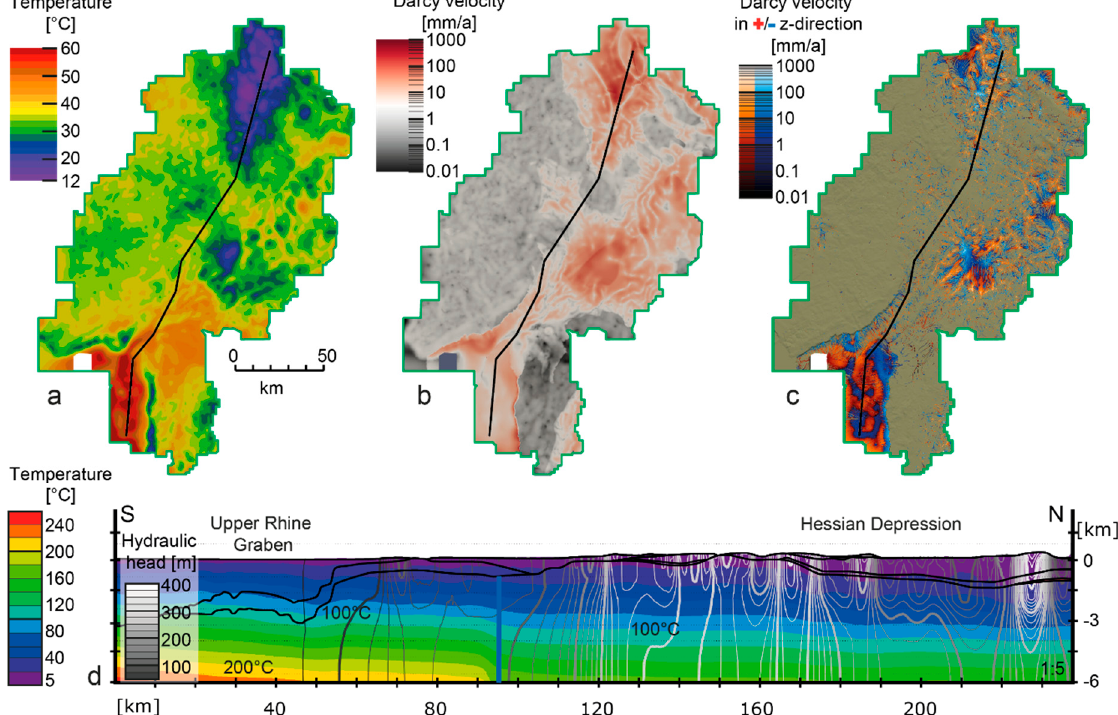
Figure 8. The thermo-hydraulic steady-state configuration from an aerial view and along the south–north profile. ( a , b ) maps of temperature distribution and Darcy velocity at 1 km depth, ( c ) Darcy velocity in the z-direction; streamlines in the sediments with red colors indicated as upflow and with blue colors indicated as downflow. ( d ) south–north profile along the black line in figure (a–c). Geological units in black lines, the background colors illustrate the temperature and grey to white lines show hydraulic head isolines.